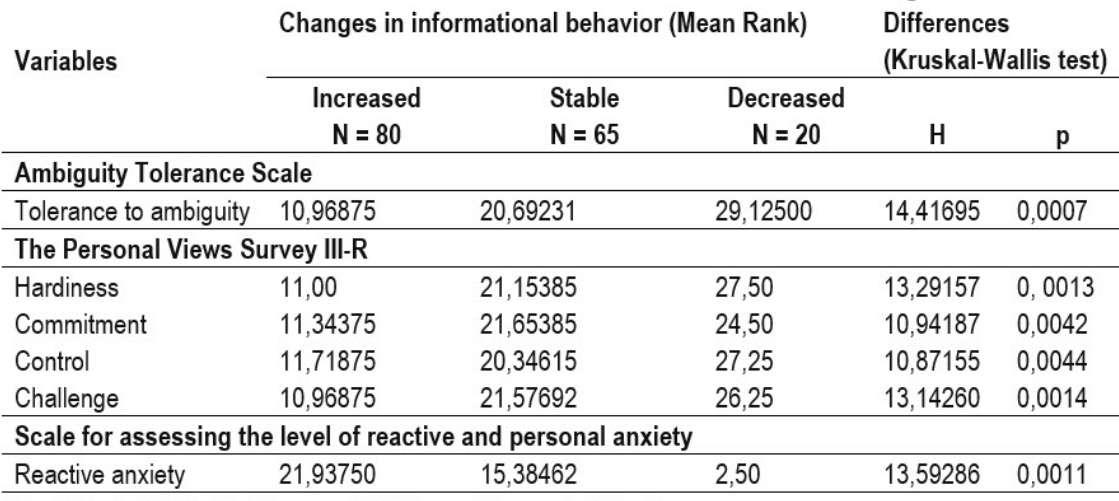
Differences in the components of hardiness, the level of tolerance to ambiguity and anxiety in groups with different informational